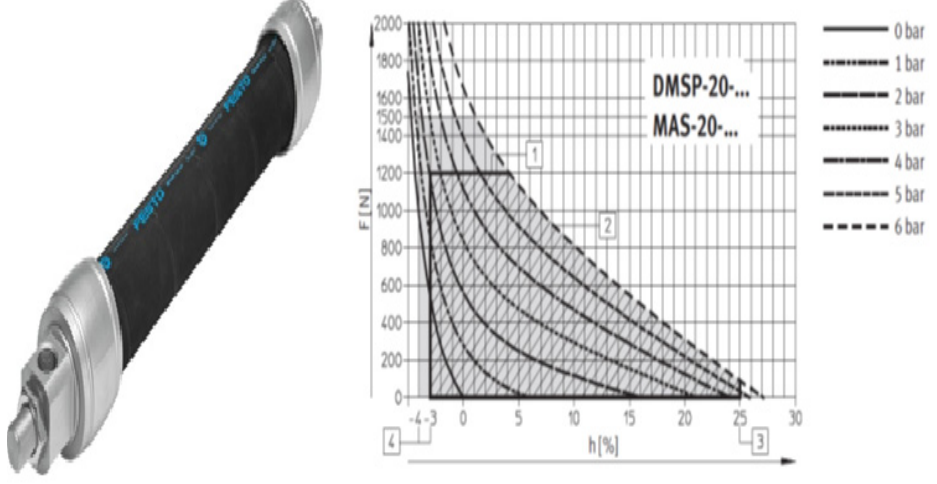
Figure 3. Festo pneumatic artificial muscle and dynamic characteristics [9].